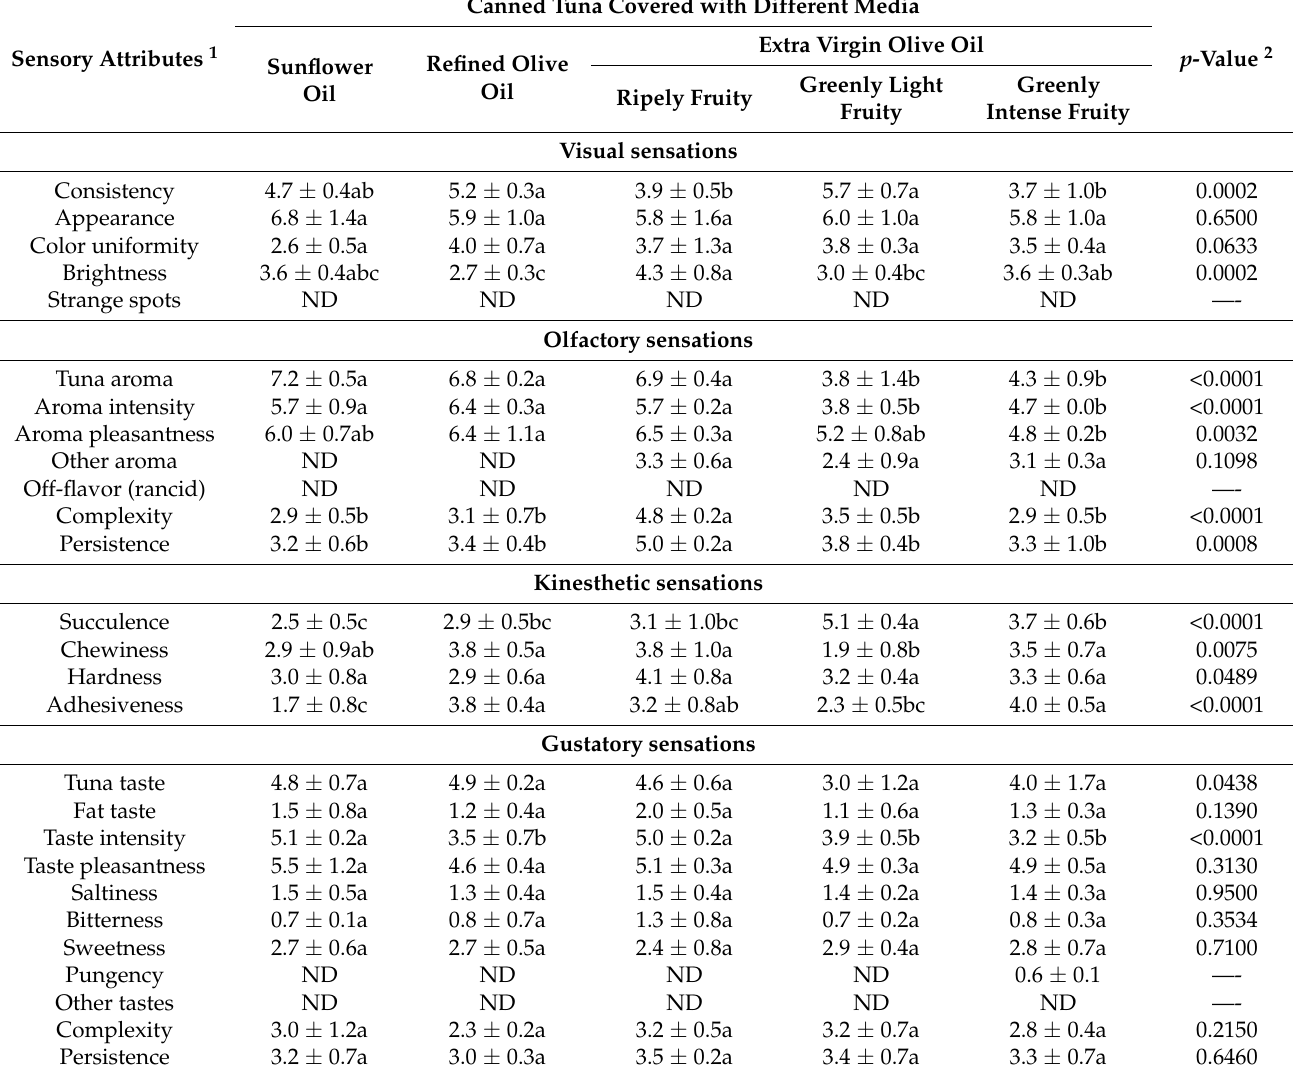
Table 4. Intensities of sensory sensations, including visual, olfactory, kinesthetic, and gustatory attributes, perceived by the trained sensory panelists (mean ± standard deviation; n = 5